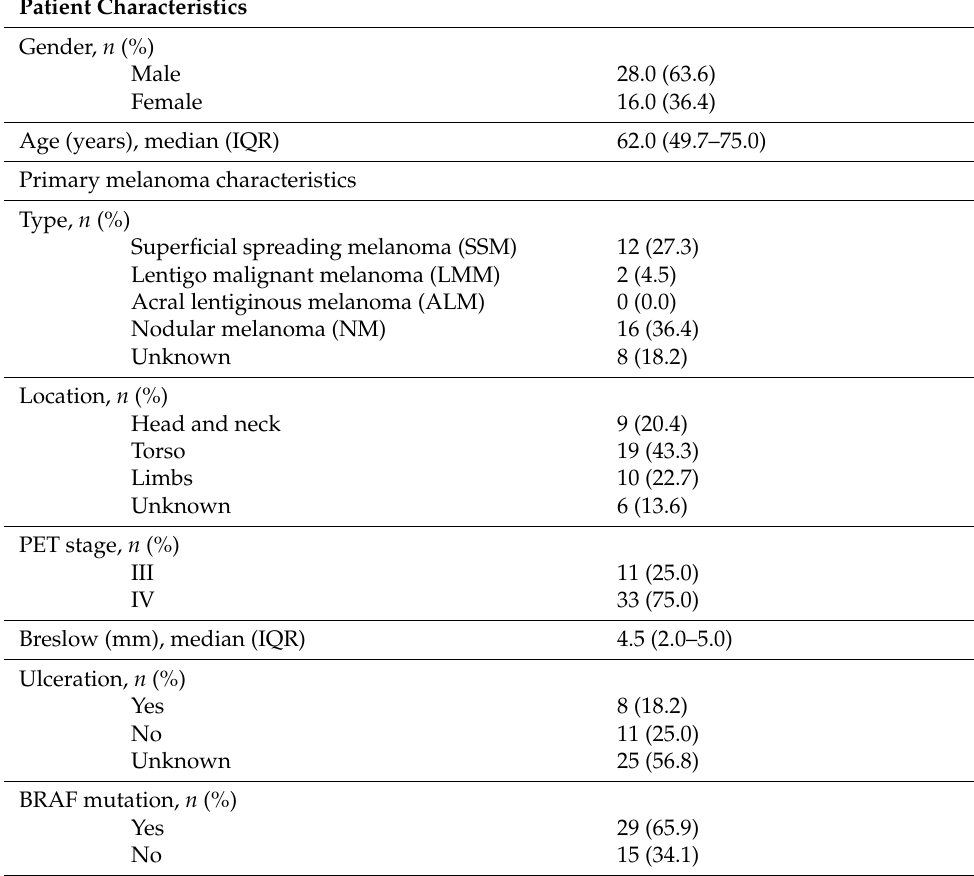
Table 1. Patient and primary tumor characteristics.